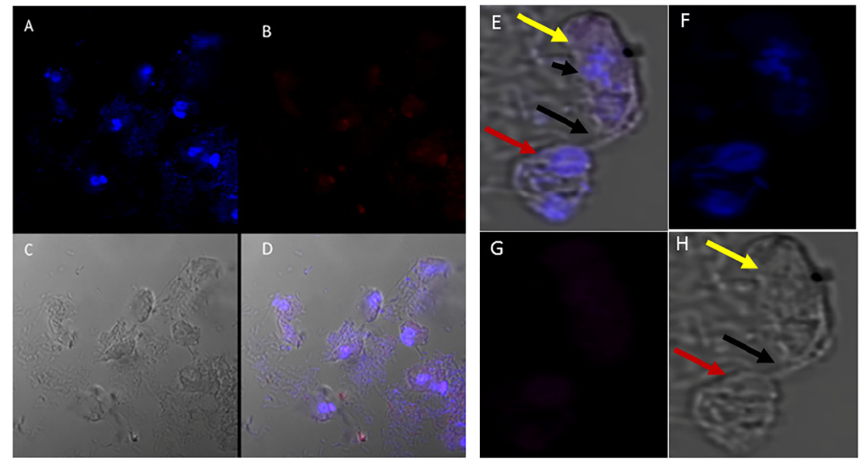
Figure 9. ( A – H ): Immunofluorescence microscopy of Colpodella sp. (ATCC 50594) trophozoites and cysts using anti-IMC7 and anti-Py 235 antibodies. ( A ), DAPI stained nuclei of Colpodella sp. (ATCC 50594) and P. caudatus , ( B ), Background to no reactivity was observed with anti-IMC7. Panels ( C ) and ( D ) shown DIC microscopy and merged Antibody, DAPI and DIC images, respectively. ( E ), Merged anti-Py235 antibody, DAPI, DIC image of Colpodella sp. (ATCC 50594) trophozoite (yellow arrow) and P. caudatus (red arrow) in myzocytosis. The tubular tether (black arrow) joining predator and prey is shown and DAPI stained aspirated cytoplasmic contents from the prey is shown (black arrowhead). ( G ), no antibody reactivity was observed and ( H ), DIC microscopy of Colpodella sp. (ATCC 50594) trophozoite and P. caudatus .